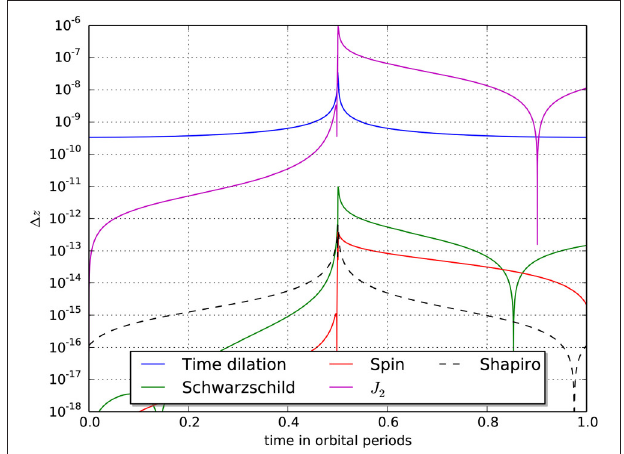
FIGURE 2 | Higher order relativistic effects for the Juno orbiter. The plot shows the magnitude of the redshift signal due to the different relativistic effects. The parameters chosen correspond to a typical science orbit. The curves change slightly for other orbits, however, the order of magnitude of the effects is the same. Also the Newtonian effect due to J 2 is shown.